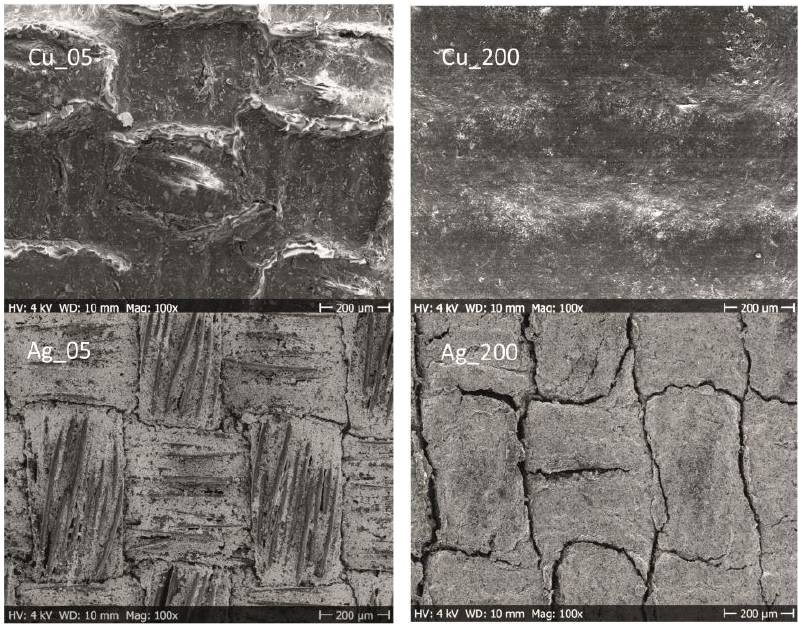
Figure 7. Top-view SEM images showing the microstructures of the coated samples after five washing cycles.